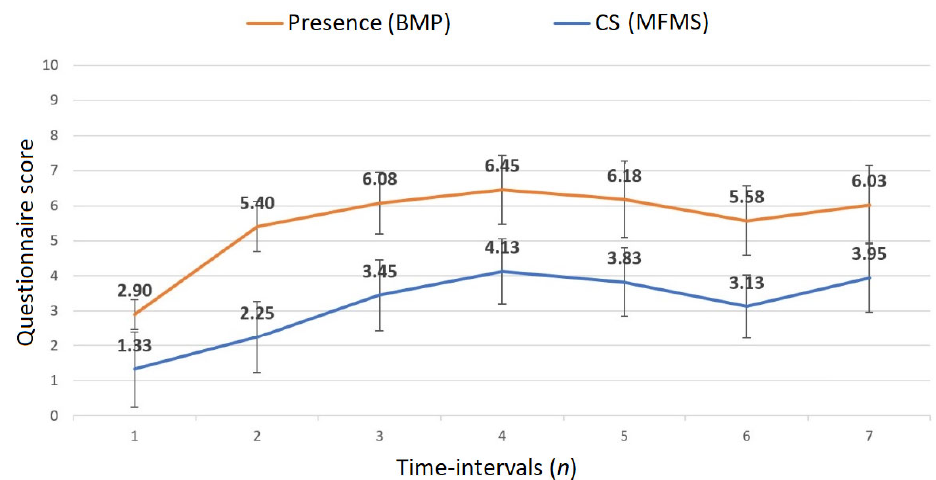
Figure 2. Mean scores for sense of presence and CS across seven time-intervals. The orange line represents MFMS scores, and the blue line represents MFMS scores. Black error bars represent standard deviations.